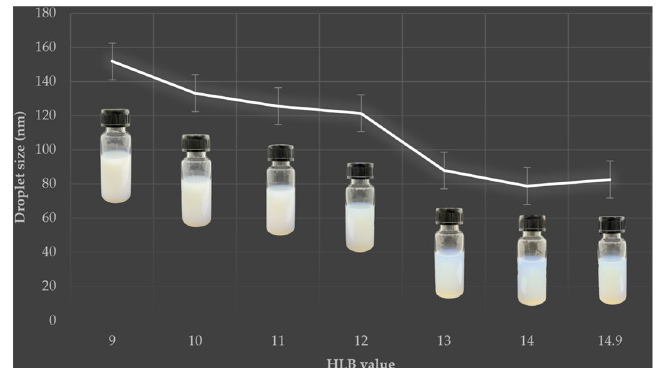
Figure 1. Effect of Smix HLB value on droplet size of the CEO-based nanoemulsion.